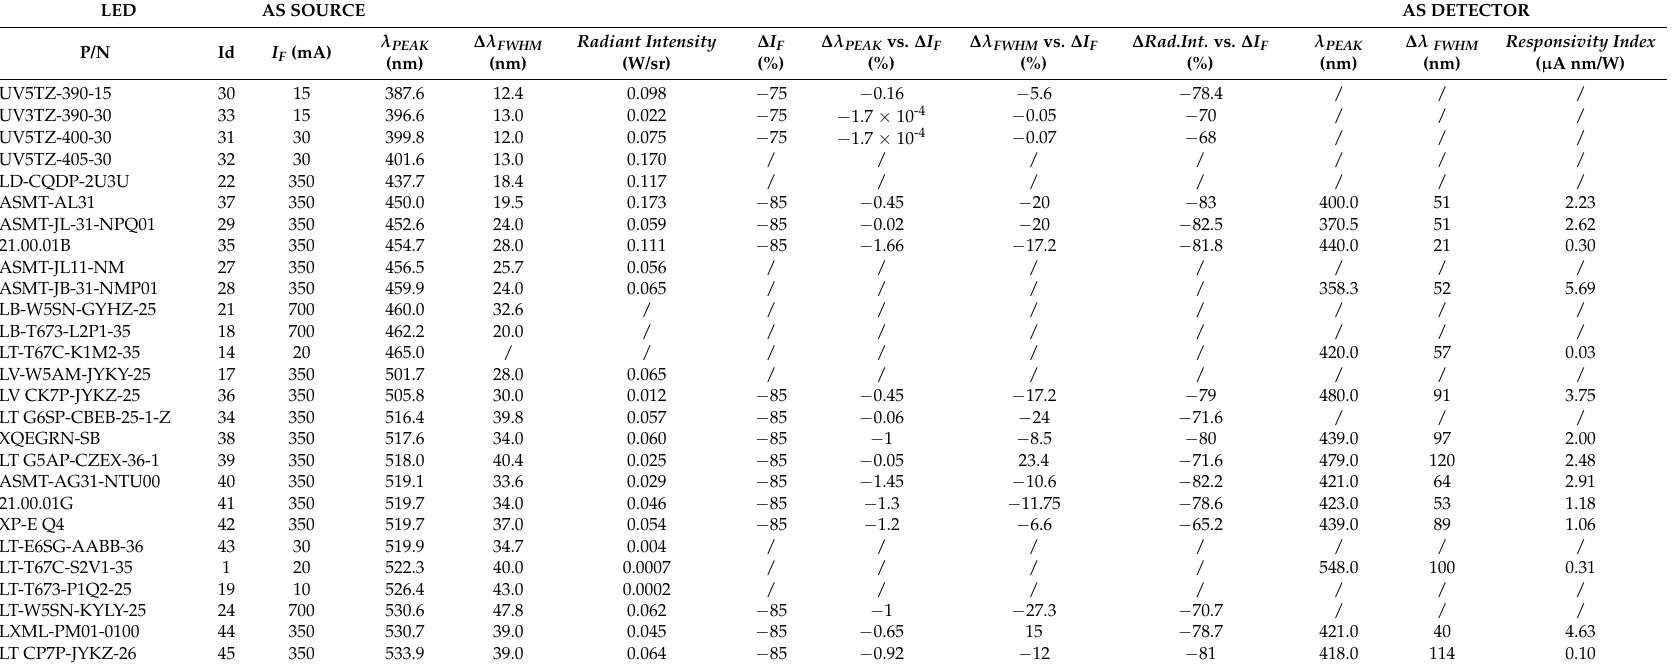
Table 1. List of LEDs characterized as sources and as detectors. The table is ordered with increasing emitted λ PEAK . LED columns legend: “P/N” is the commercial part number of the device under test; “Id” is the identification number that we gave to the part number in our tests, (in the following, “E” stands for emitting properties (reported in “AS SOURCE” columns) and “D” stands for detection properties (“AS DETECTOR” columns)). AS SOURCE columns legend: “ I F ” is the forward test current; “ λ PEAK ” is the wavelength of maximum emission; “ ∆ λ FWHM ” is the emission bandwidth at full width at half maximum; “ Radiant intensity ” is the averaged LED radiant intensity measured with CIE method A; “ ∆ λ PEAK ”, “ ∆ λ FWHM ” and “ ∆ Rad.Int. vs. ∆ I F ” are the percentage variation of, λ PEAK , λ FWHM and Radiant intensity , respectively, measured when I F is changed according to “ ∆ I F ”. AS DETECTOR columns legend: λ PEAK is the wavelength of maximum sensitivity of the LED, ∆ λ FWHM is the sensitivity bandwidth at full width at half maximum; “ Responsivity index ” is calculated by applying Equation (1) and then Equation (4) (see text). LED AS SOURCE AS DETECTOR